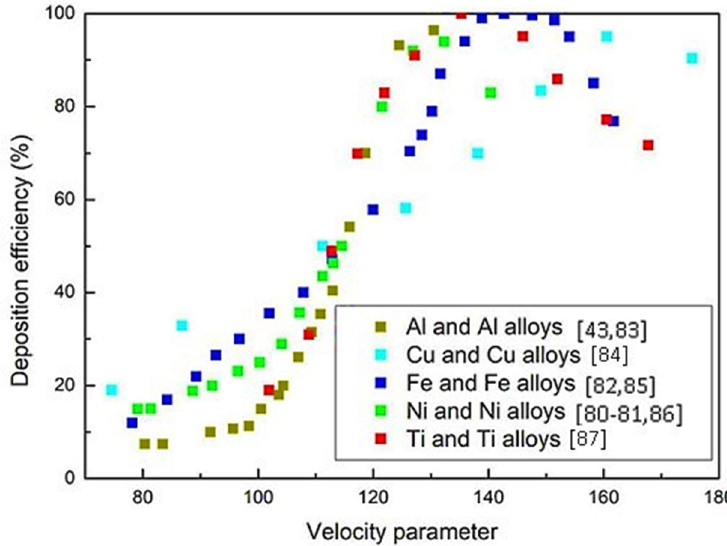
Figure 8. Deposition efficiency as a function of the velocity parameter for different alloys [43,80–87].